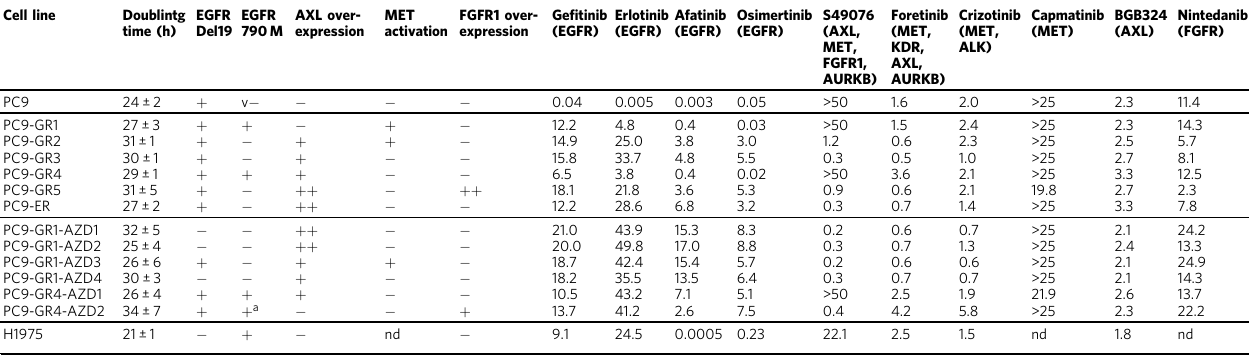
Table 1 Characteristics (left) and IC50s ( µ M, right) for selected drugs of the PC9-derived cell lines used in the study Cell